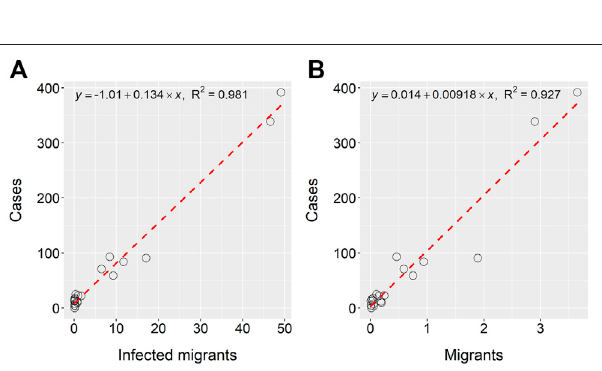
FIGURE 9 | Relationship between con fi rmed COVID-19 cases and population migration. (A) Number of infected migrants calculated using the Baidu Qianxi migration data and incidence rate and (B) number of migrants calculated directly using the Baidu Qianxi migration data.